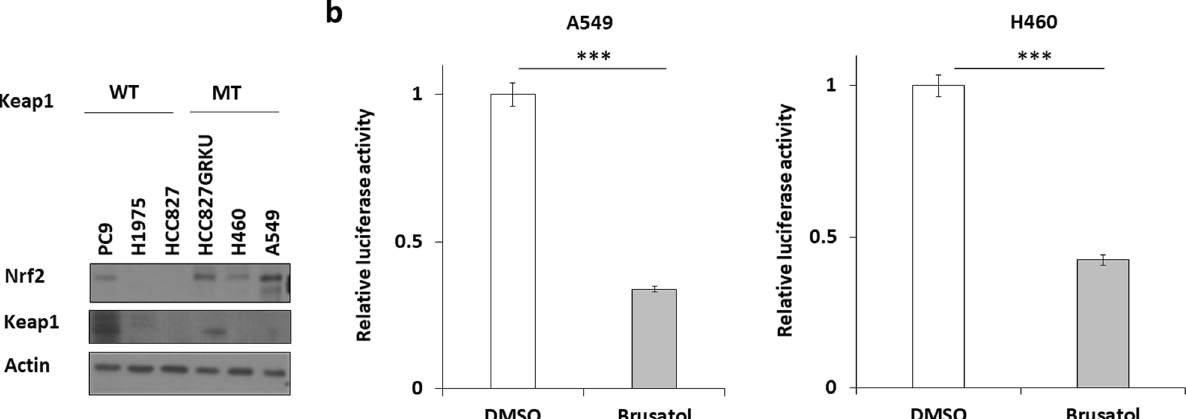
Figure 1. Expression levels of Nrf2 and Keap1 in NSCLC cells and inhibitory effect of brusatol on Nrf2 expression. ( a ) Nrf2 and Keap1 expression levels in different types of NSCLC cells were evaluated using Western blotting. ( b ) Inhibition of Nrf1 transcriptional activity seen after evaluation of ARE using dual luciferase assay after treatment with brusatol in H460 (10 nM) and A549 (30 nM) cells for 24 h.Expression levels of Nrf2 and Keap1 in NSCLC cells detected by western